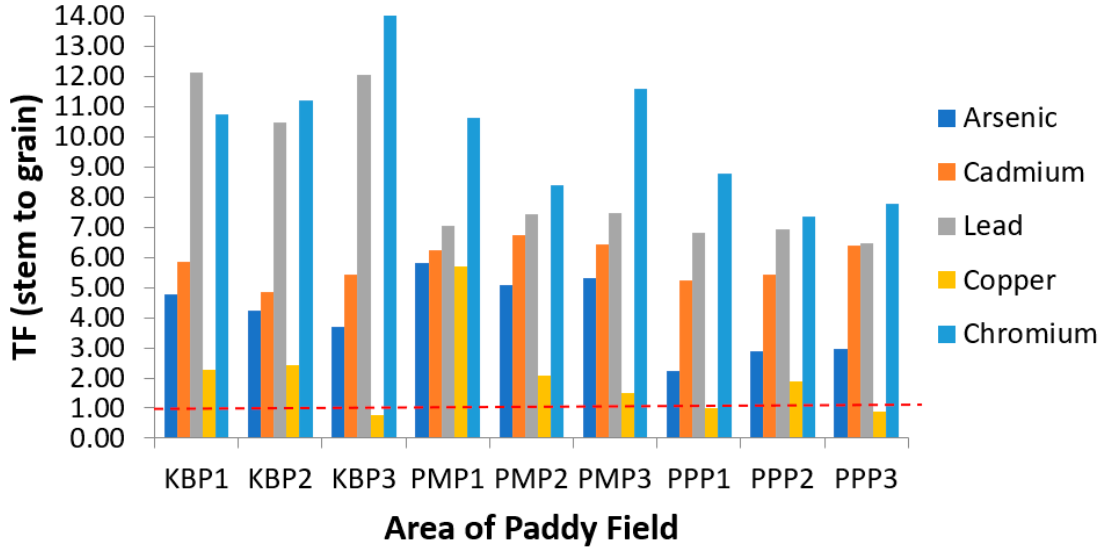
Figure 6. Translocation factor of the heavy metals from stem to grain (TF Stem ) at different sampling sites. KBP1: